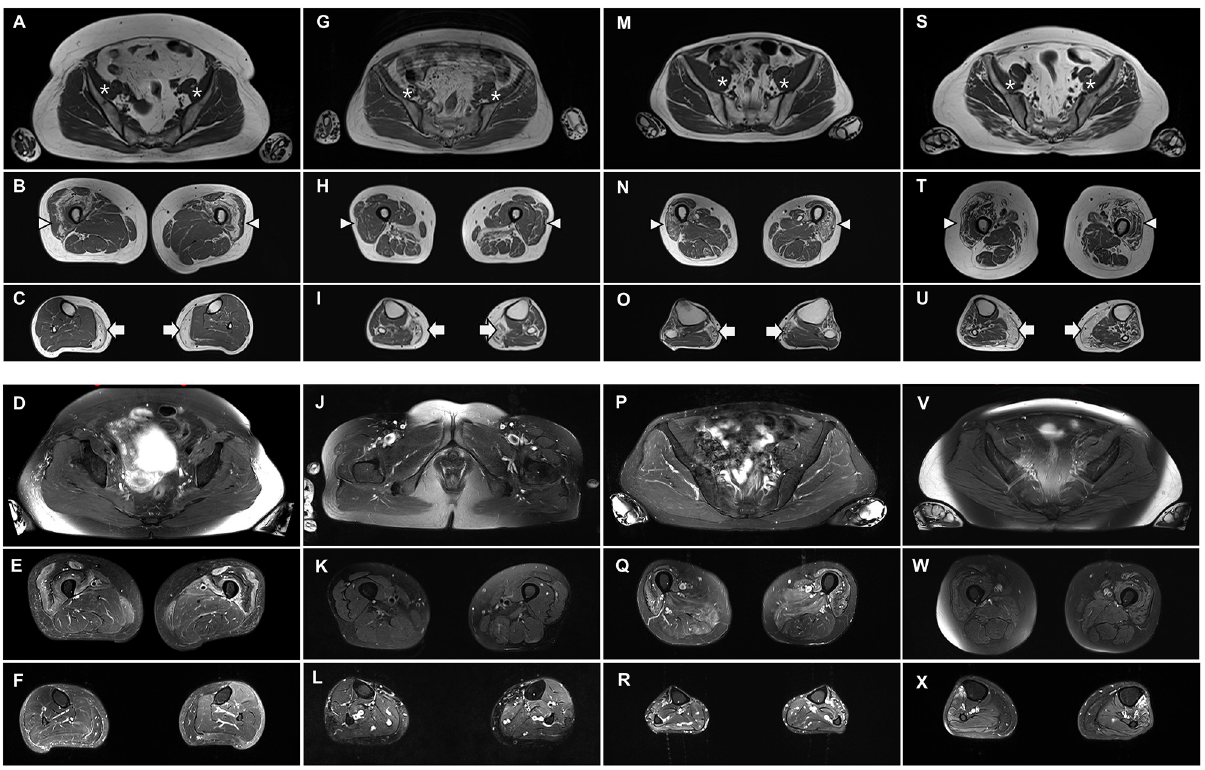
Fig 3. Lower limb magnetic resonance images of four inclusion body from patients with myositis and seropositive for anti-NT5c1A antibody: P2 (A-F), P6(G-L), P7(M-R), and P1 (S-X) taken 45, 55, 70, and 84 months after symptom onset, respectively.